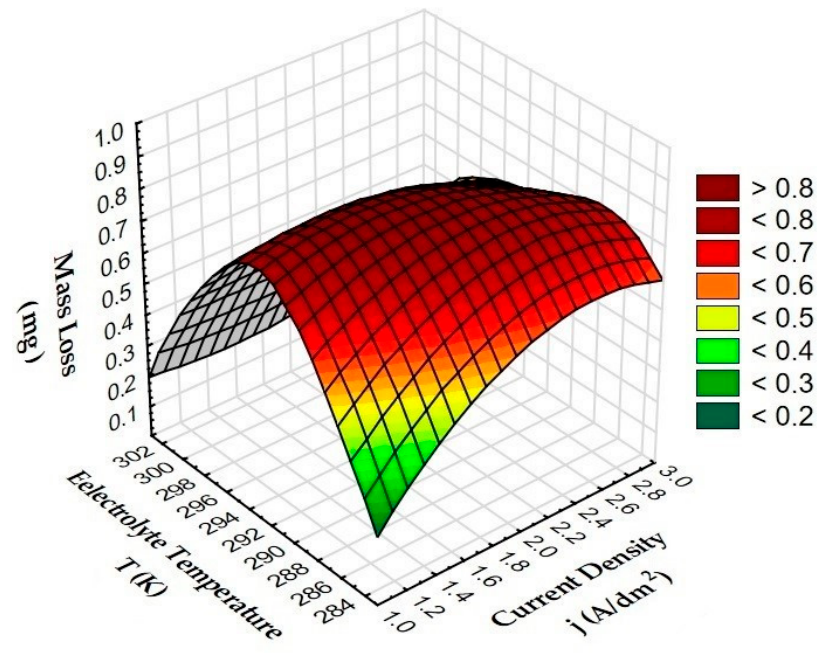
Figure 10. Dependence of mass loss of T7W material on the current density and electrolyte tempera- ture during anodizing.